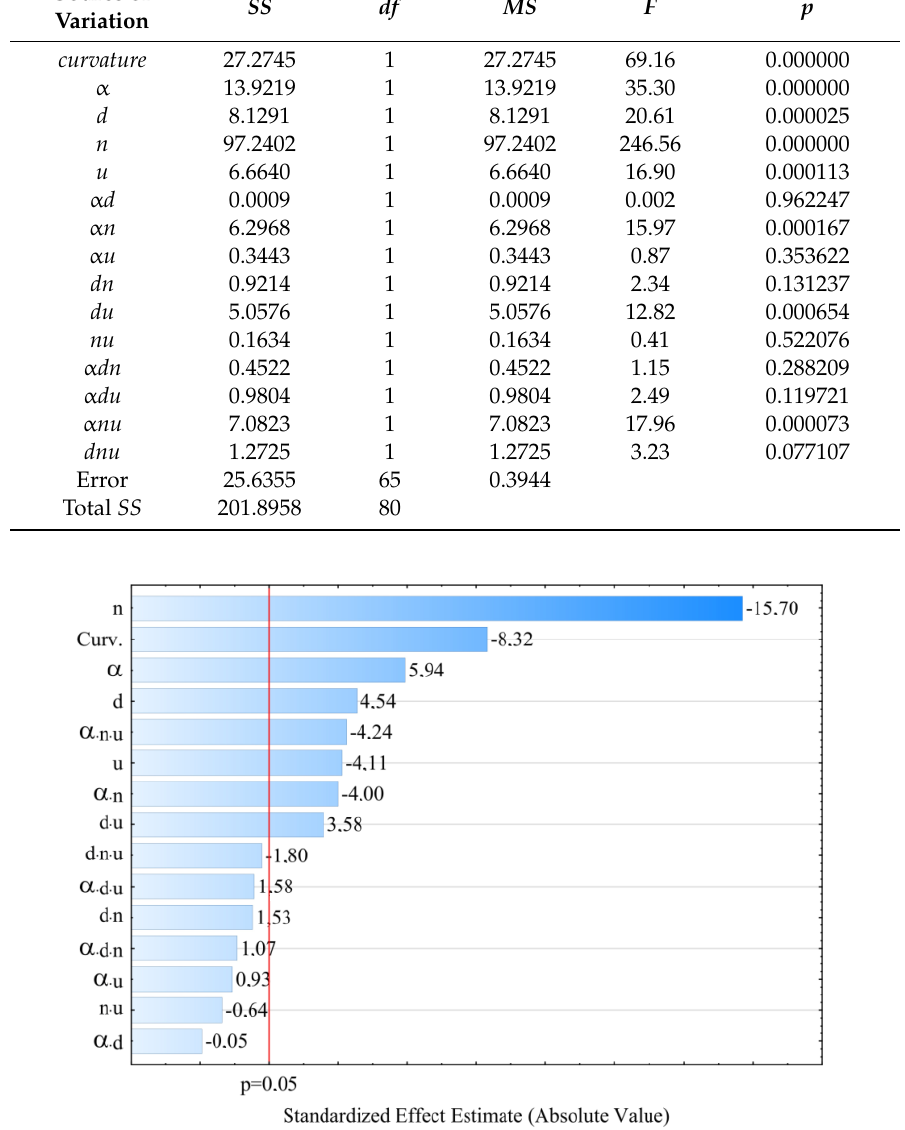
Table 3. Model of tensile strength σ –ANOVA table. R 2 = 0.87; R adj2 = 0.84 (markers as in Table 2).